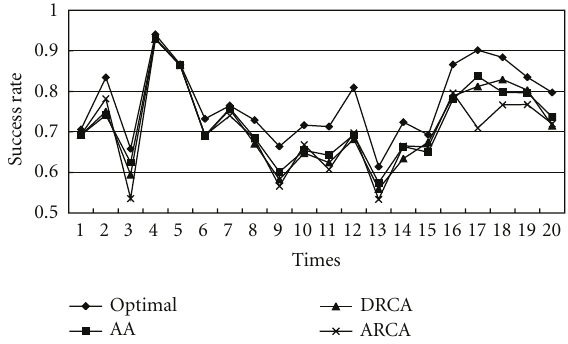
Figure 9: Total transmission success rate in Case 5.